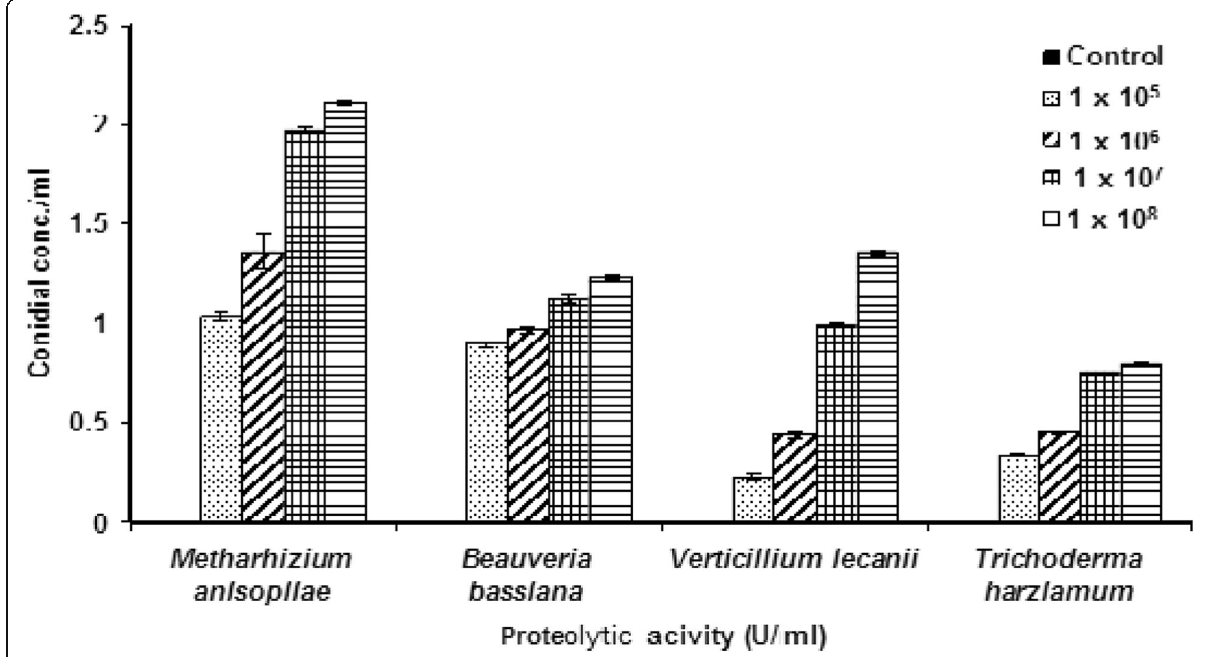
Fig. 6 Mean (± SE) proteolytic activity (U/ml) of different EPF isolates on casein